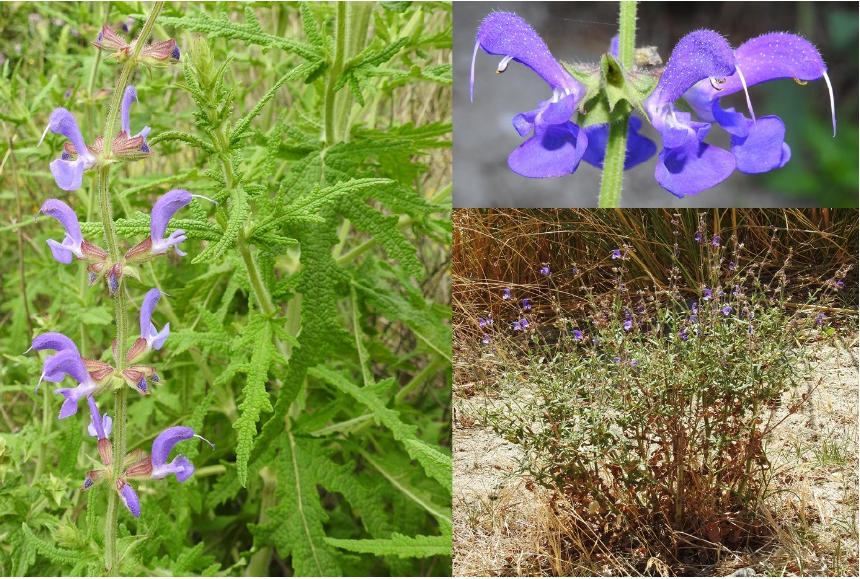
Figure 1. Details of the inflorescence, flowers, and habitat of Salvia ceratophylloides Ard. in its natural habitat (Ph. V.L.A. habitat (Ph. V.L.A. Laface).